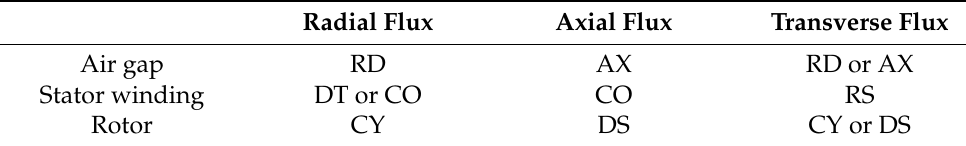
Table 1. Electric machine types according to flux